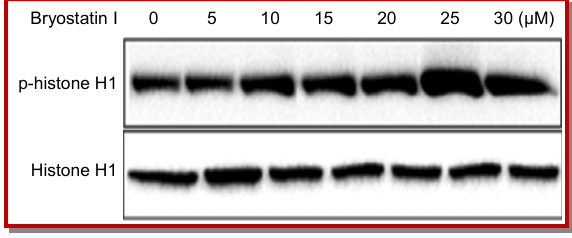
Figure 4: Bryostatin I treatment inhibits the expression of his- tone H1 protein. The cells were incubated with 25 µM concen- tration of bryostatin I for 48 hours. After incubation phosphory- lation of the histone H1 protein was analyzed using Western